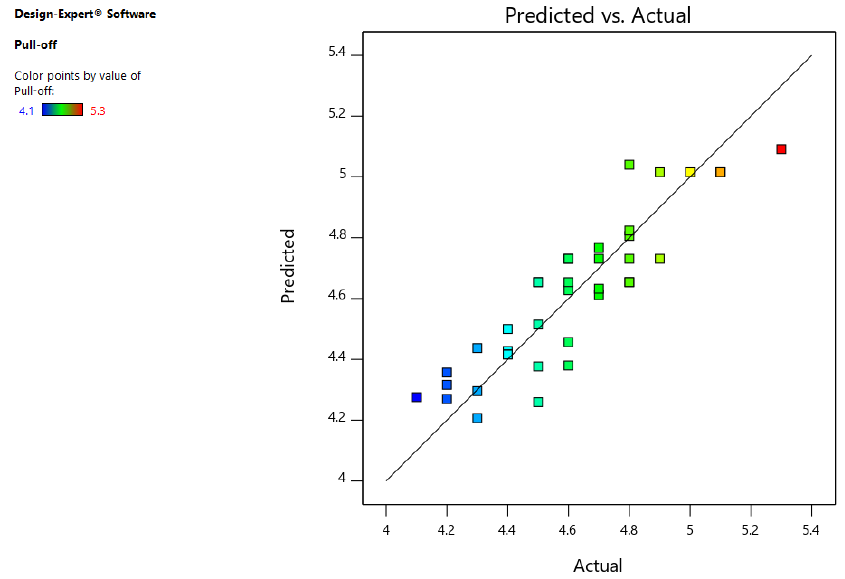
Figure 8. Presentation of actual and predicted values for adhesion force.